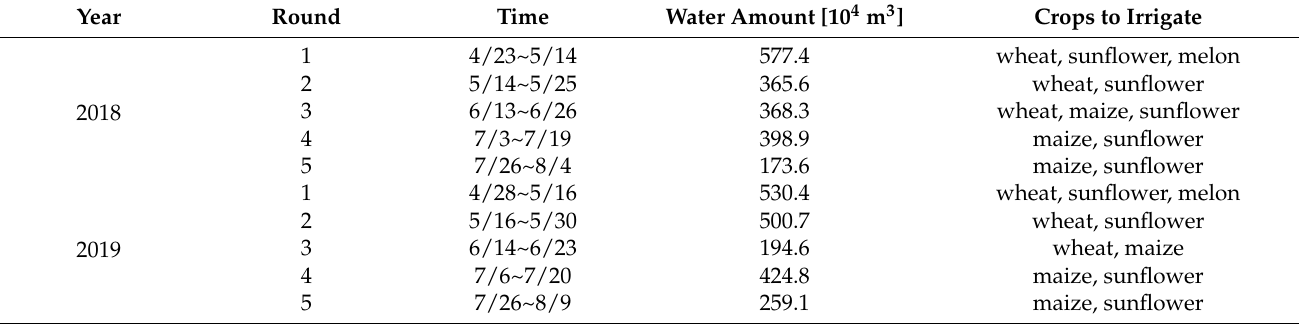
Table 2. Irrigation